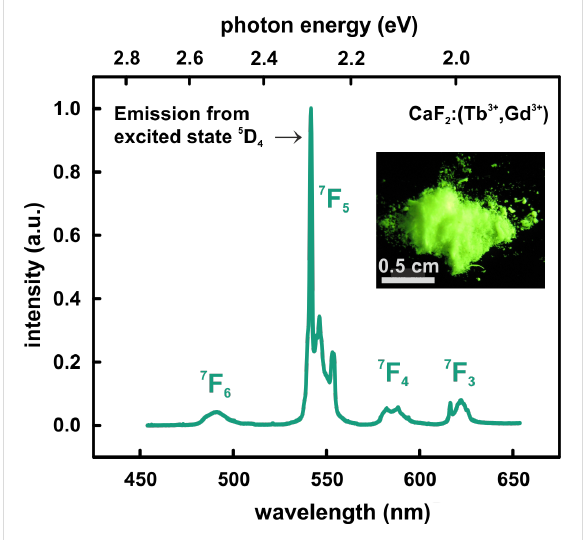
Figure 3: Normalized photoluminescence spectrum of CaF 2 :(Tb 3+ ,Gd 3+ ) NPs at an excitation wavelength of λ exc = 254 nm. The emission spectrum shows several maxima (490, 542, 586 and 622 nm), which represent the Tb 3+ -related transitions from the 5 D 4 excited state to the energy levels indicated. The maximum intensity occurs in the green spectral range at a wavelength of λ = 542 nm. Inset: CaF 2 :(Tb 3+ ,Gd 3+ ) NP powder under UV light excitation ( λ exc = 254 nm). The green luminescence matches the maximum of the emission